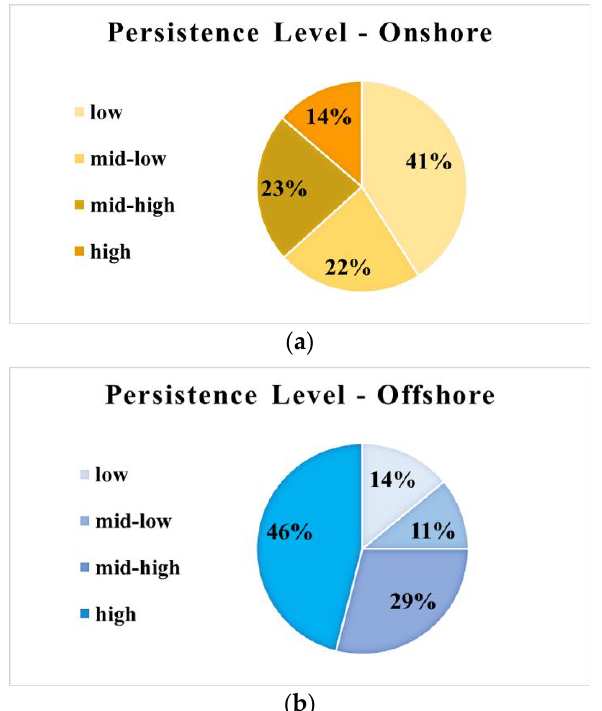
Figure 5. OFs distribution among the four persistence classes for the ( a ) onshore and ( b ) offshore sites.